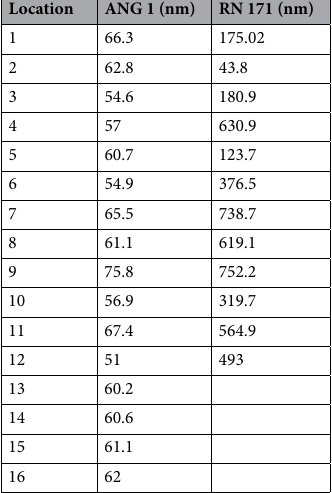
Table 1. Results of plastic deformation calculated using force-distance spectroscopy on ANG 1 and RN 171. The deformation of the surface in case of ANG 1 is significantly lesser than that of RN 171 implying greater strength of the surface of ANG 1 in all domains, compared to RN